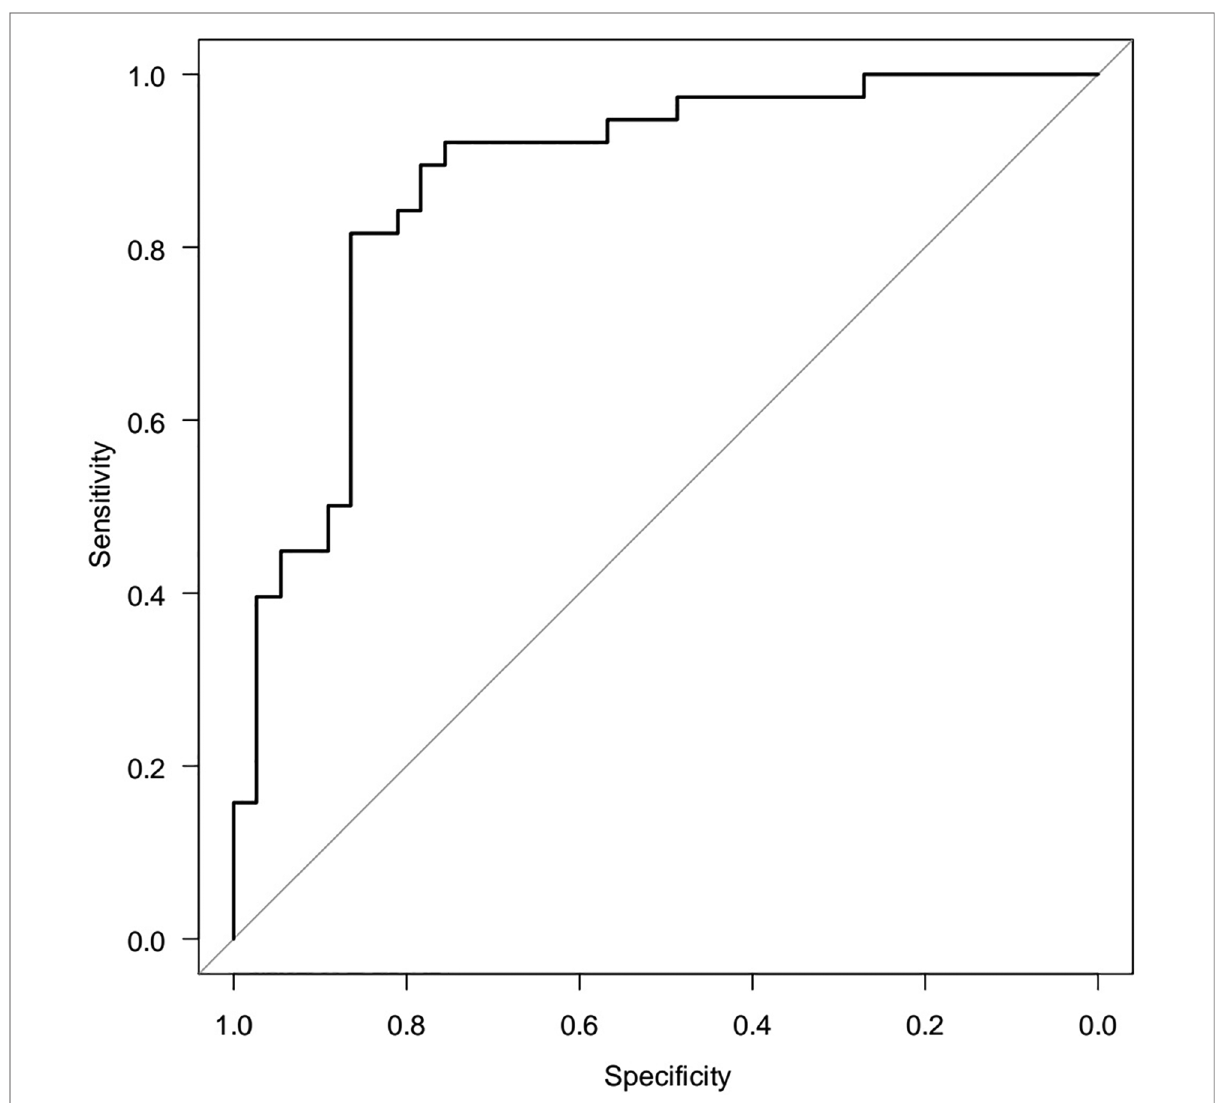
FIGURE 5 ROC-curve two-factor logistic regression model (AUC=0.876 95% CI 0.794 –